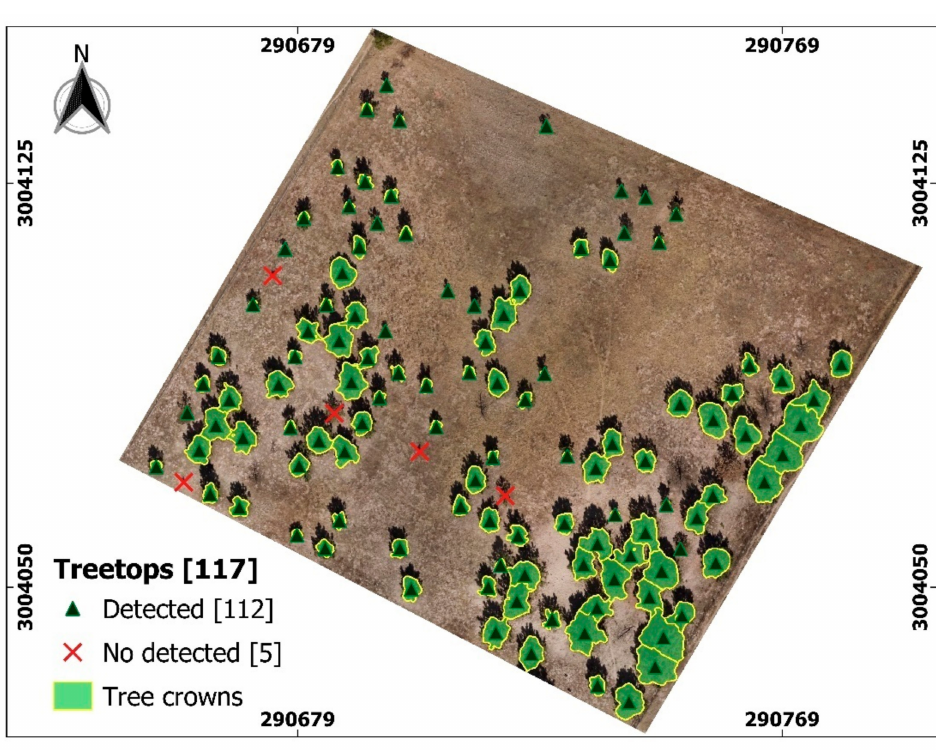
Figure 5. Detection and delimitation of individual tree crowns from canopy-height model (CHM) with the ForestTools